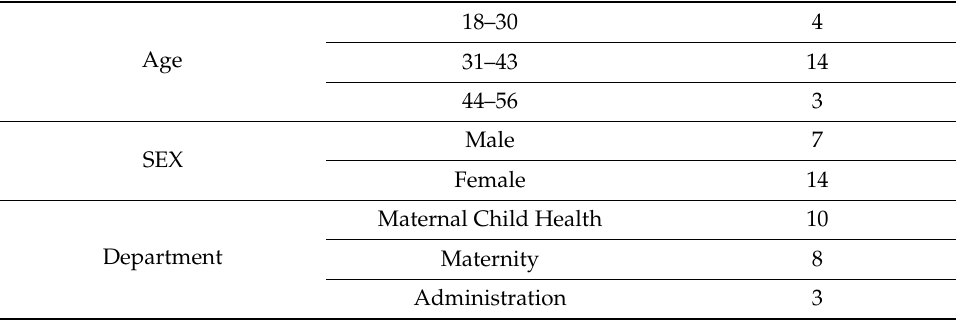
Table 1. The sociodemographic characteristics of the